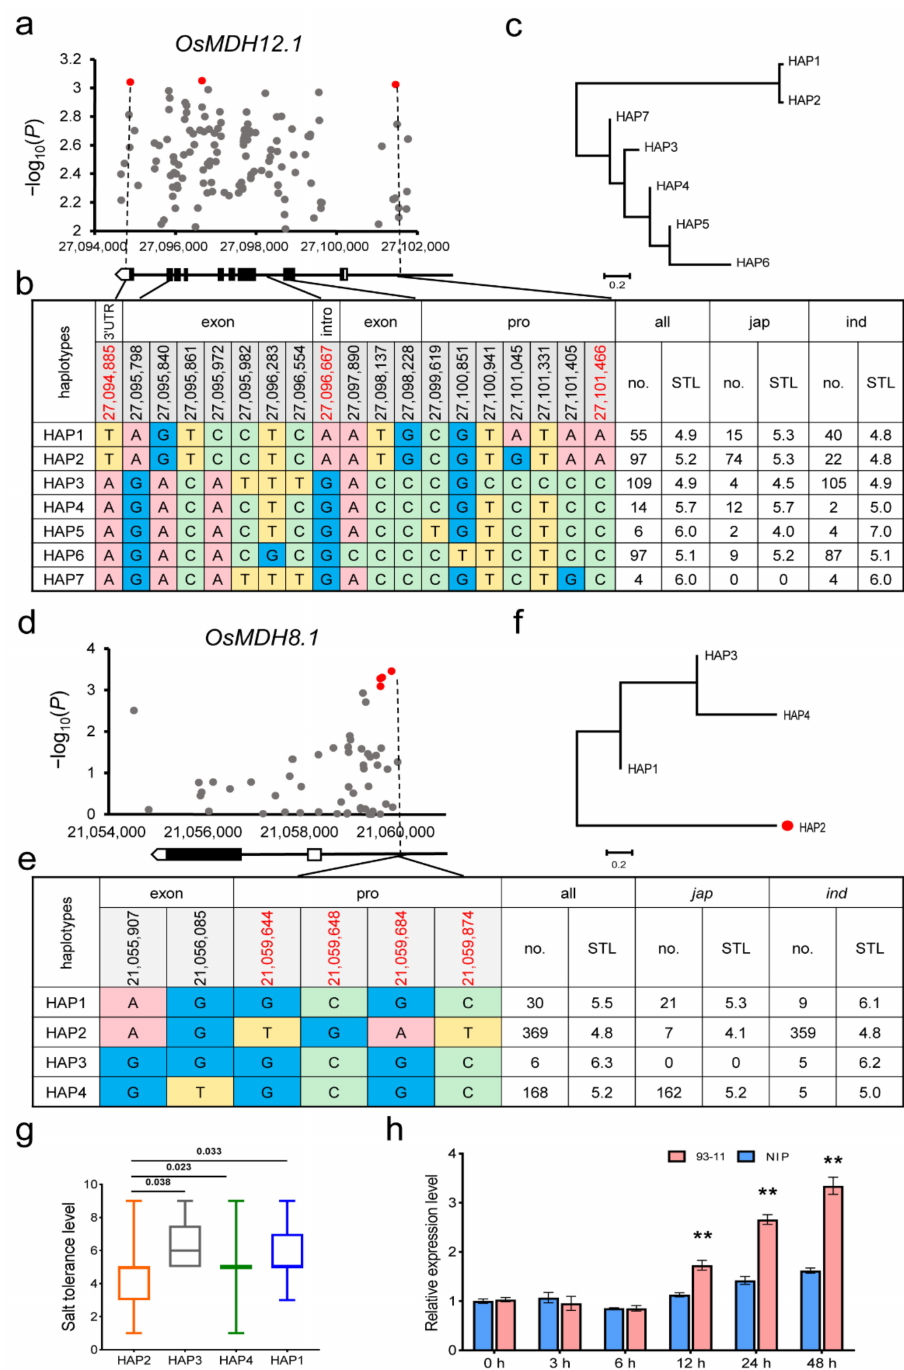
Figure 5. Association analysis and haplotype analysis of OsMDH12.1 and OsMDH8.1 with rice salt tolerance. ( a ) Red dots represent significant SNPs detected in OsMDH12.1 related to salt tolerance level, and a gene structure diagram is shown below it. ( b ) Seven OsMDH12.1 haplotypes and